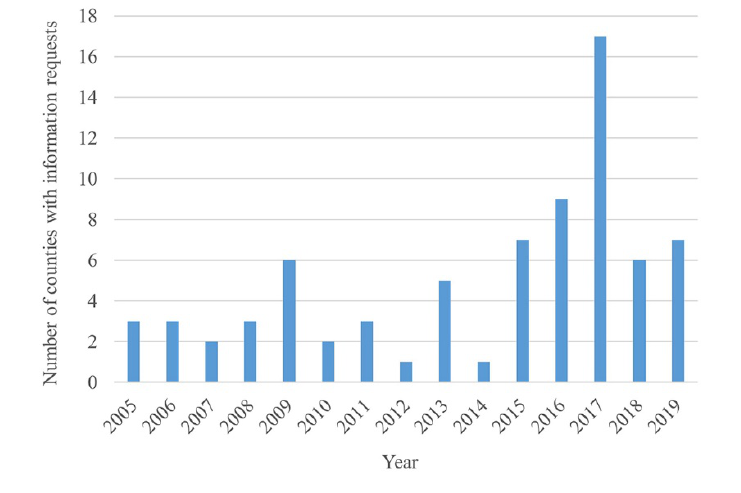
Figure 2 Number of different counties represented in HIC information requests about mental health, pain, and substance